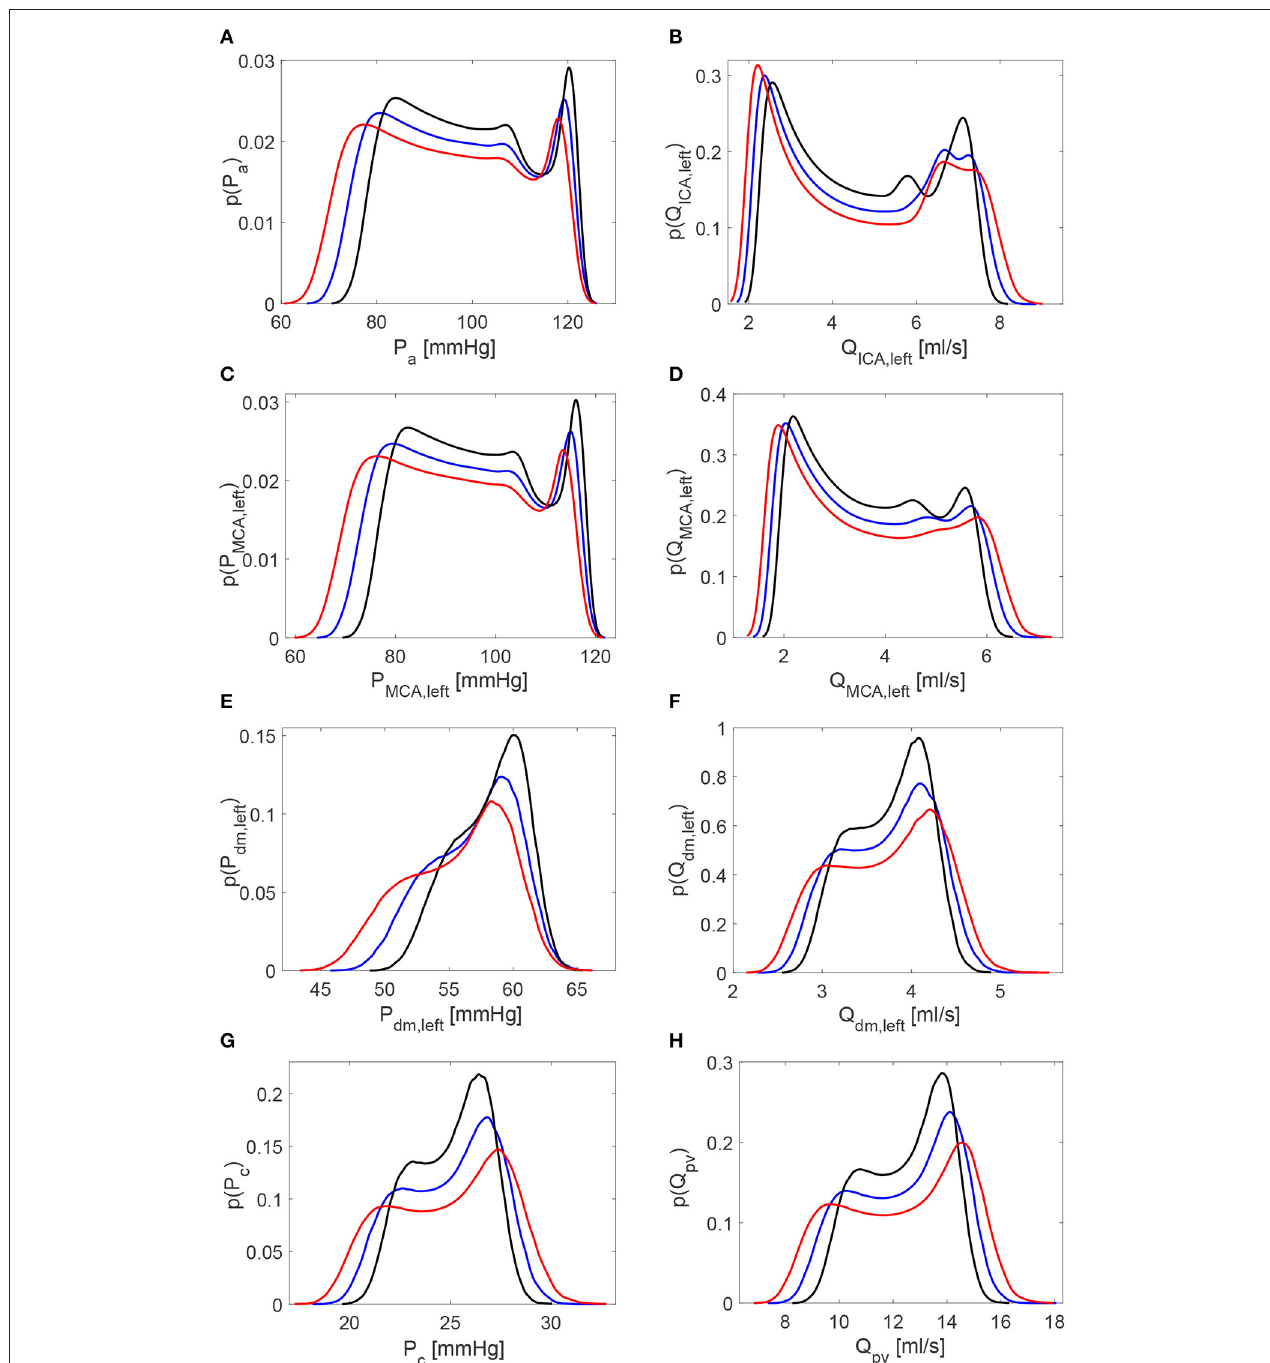
FIGURE 4 | Probability density functions of the continuous hemodynamic time-series along the ICA-MCA pathway. (A,C,E,G) Pressures. (B,D,F,H) Flow rates. Black: decreased HRV; blue: baseline; red: increased HRV.